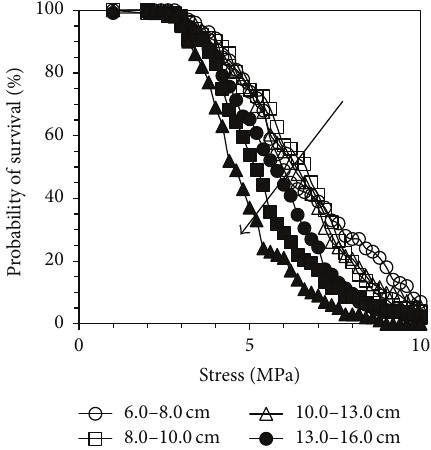
Figure 9: Comparisons of predictions with experimental data of crushing strength.